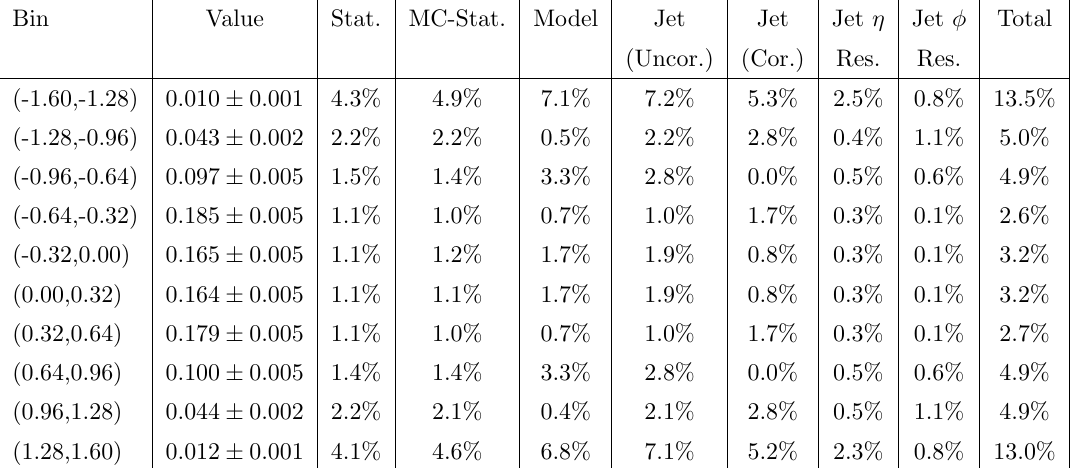
Table 4 . Unfolded normalized distribution of (cid:11) in the (cid:12)ducial volume including and a summary of statistical and systematic